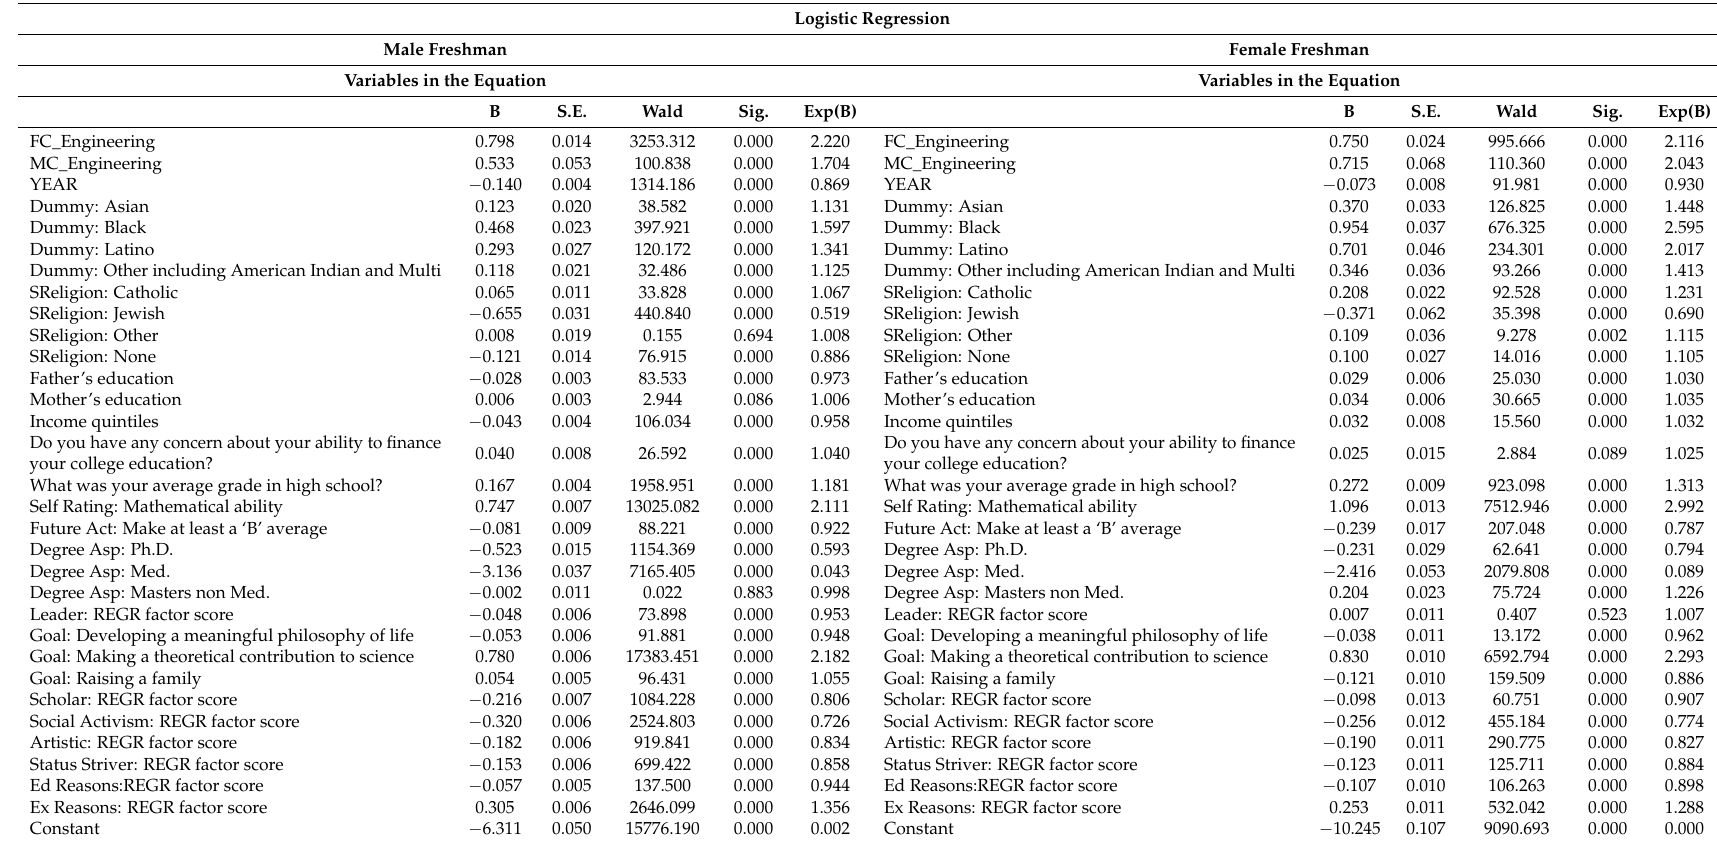
Table A3. Logistic Regression Results: Final